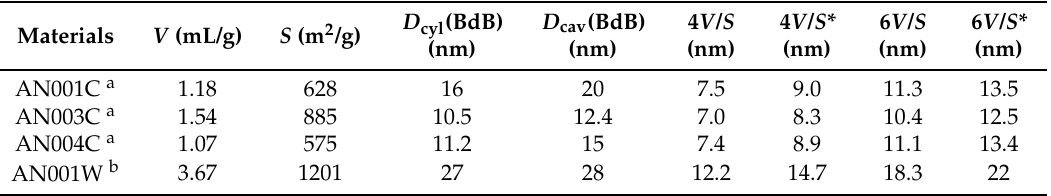
Table 3. Textural properties of mesoporous silica